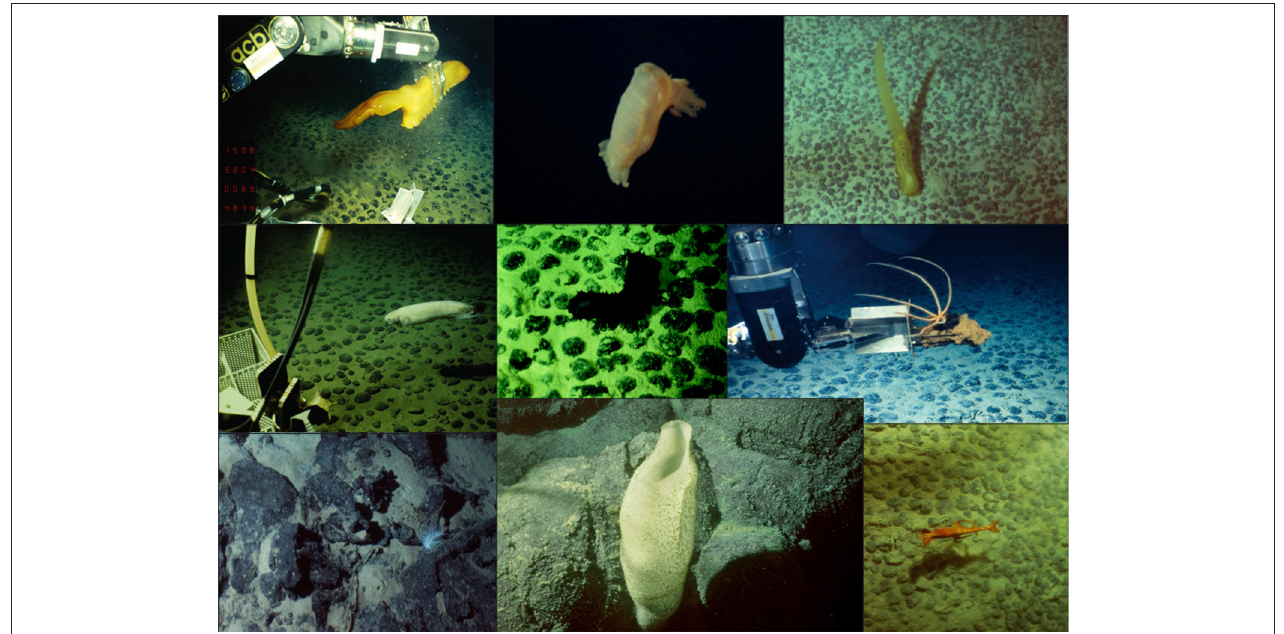
FIGURE 1 | Photos of megafauna in the nodule ecosystem taken by the manned submersible “Nautile.” From top left to bottom right starting from top: (1) Holothurian Psychropotes longicauda being collected over facies C 15% © IFREMER; (2) Swimming Holothurian Peniangone leander © IFREMER; (3) Holothurian Psychropotes longicauda on facies C 40% © IFREMER; (4) Fish Ophidiid Barathrites sp., over facies C15% © IFREMER; (5) Holothurian Psychronaetes hanseni on facies C20% © IFREMER; (6) Crustacean Decapoda Plesiopenaeus sp. or Aristaeomorpha sp. © IFREMER; Source: Tilot